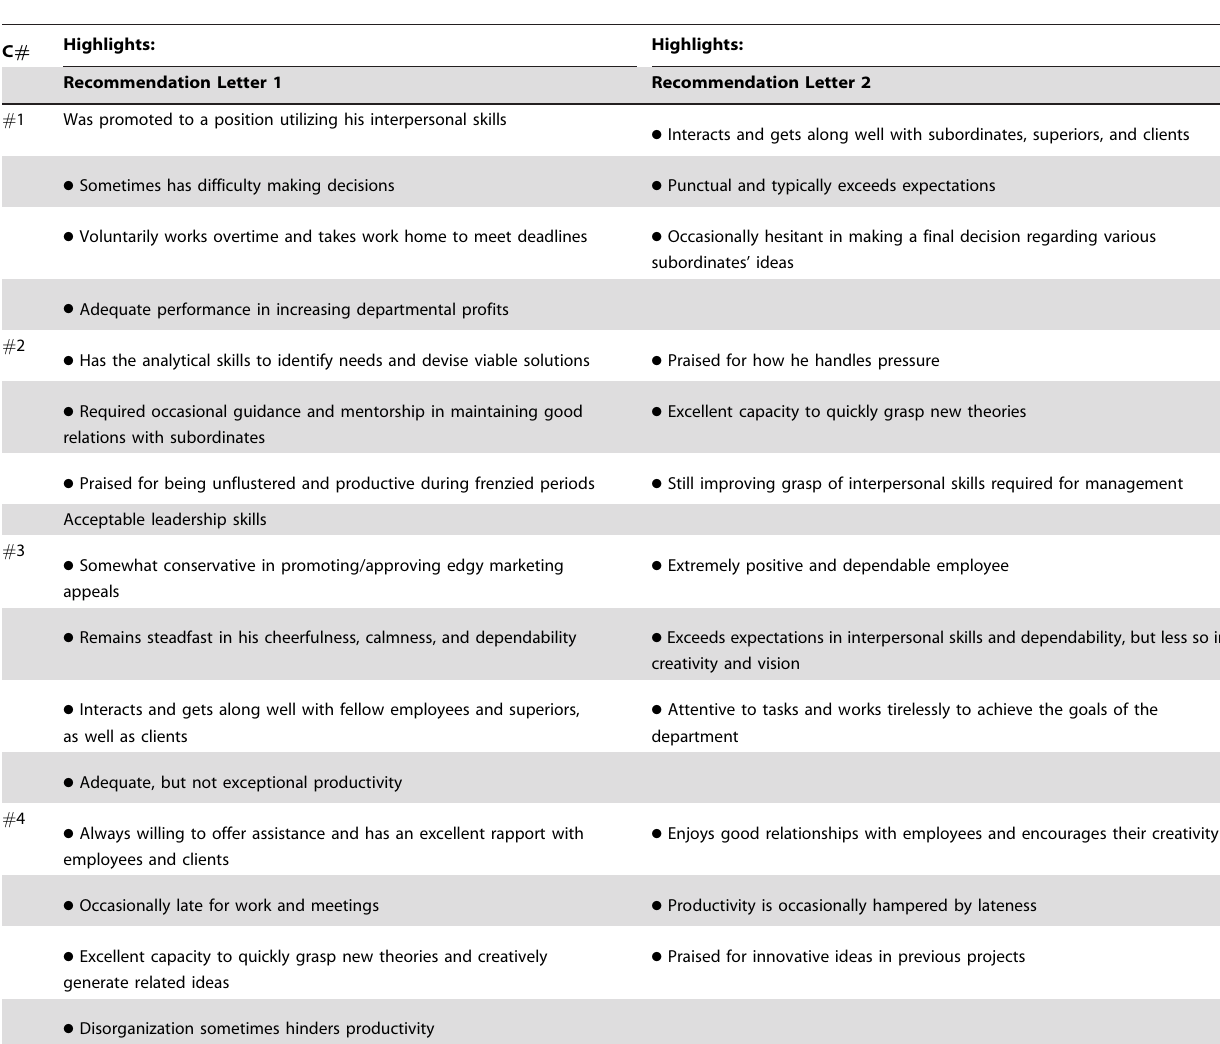
Table 1 . Content of recommendation letter highlights for 4 counterbalanced job